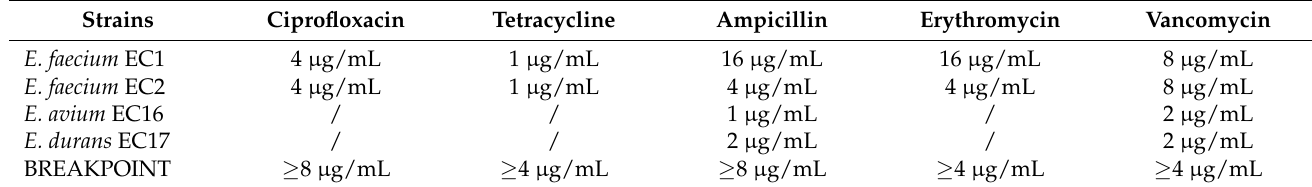
Table 2. MIC values for Enterococci strains and their Break Point values.